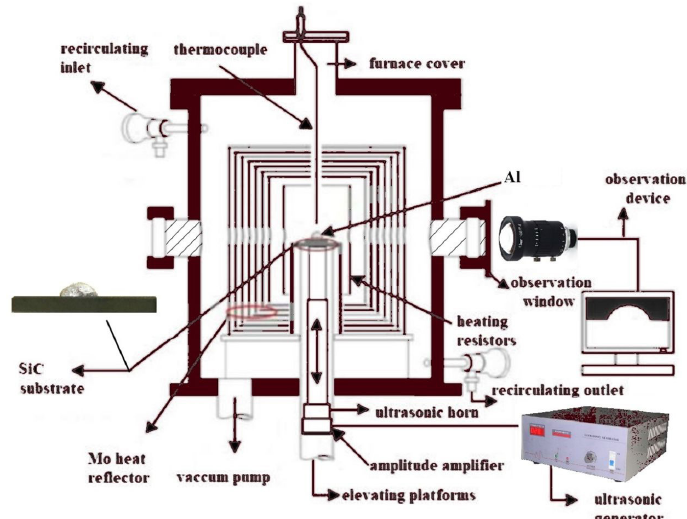
Figure 1. Schematic diagram of the ultrasonic device for wetting